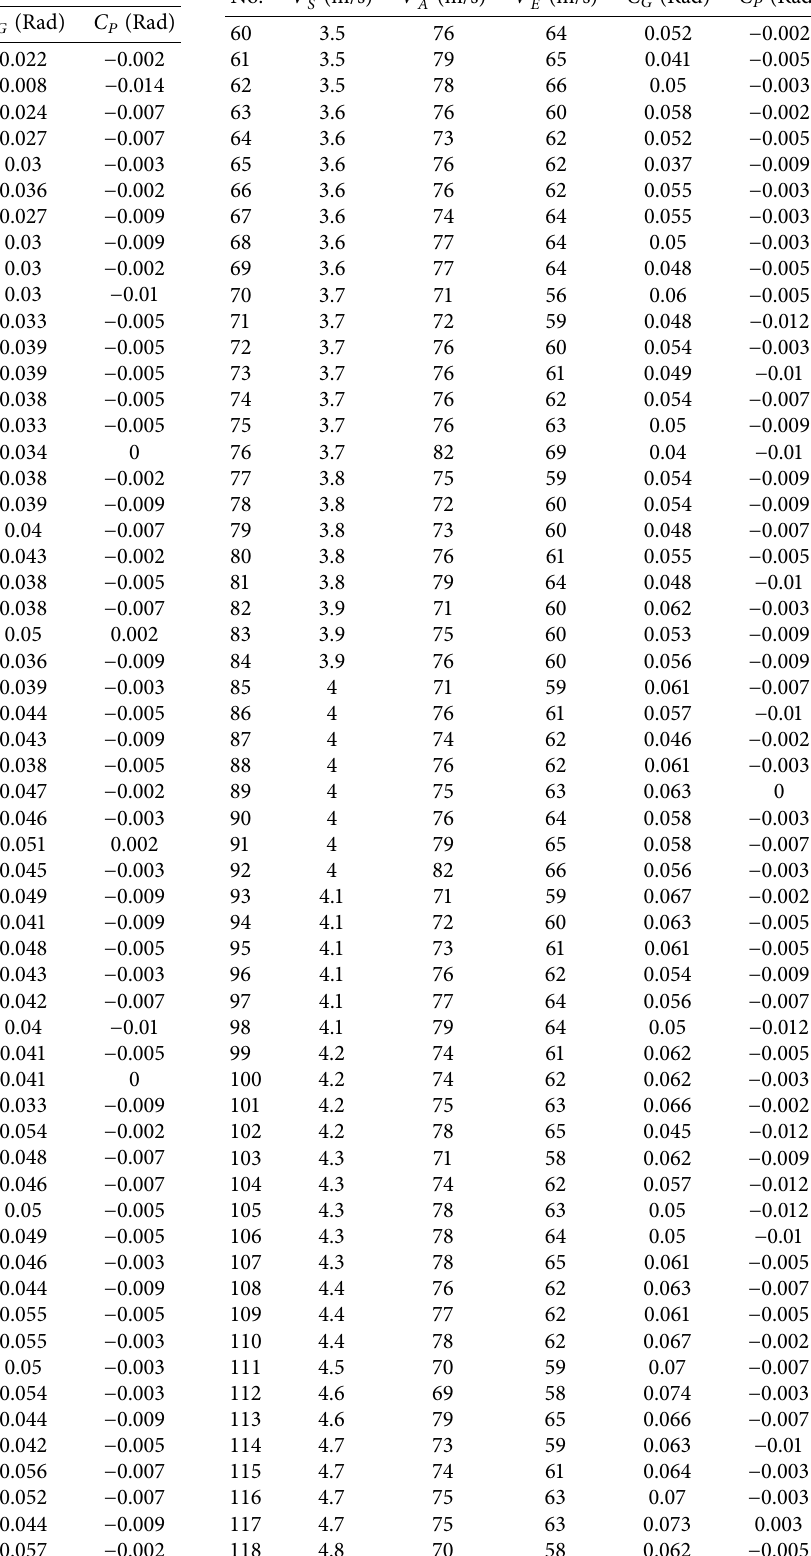
Table 2: The sinking velocity and correlated parameters sample for IK-RSM